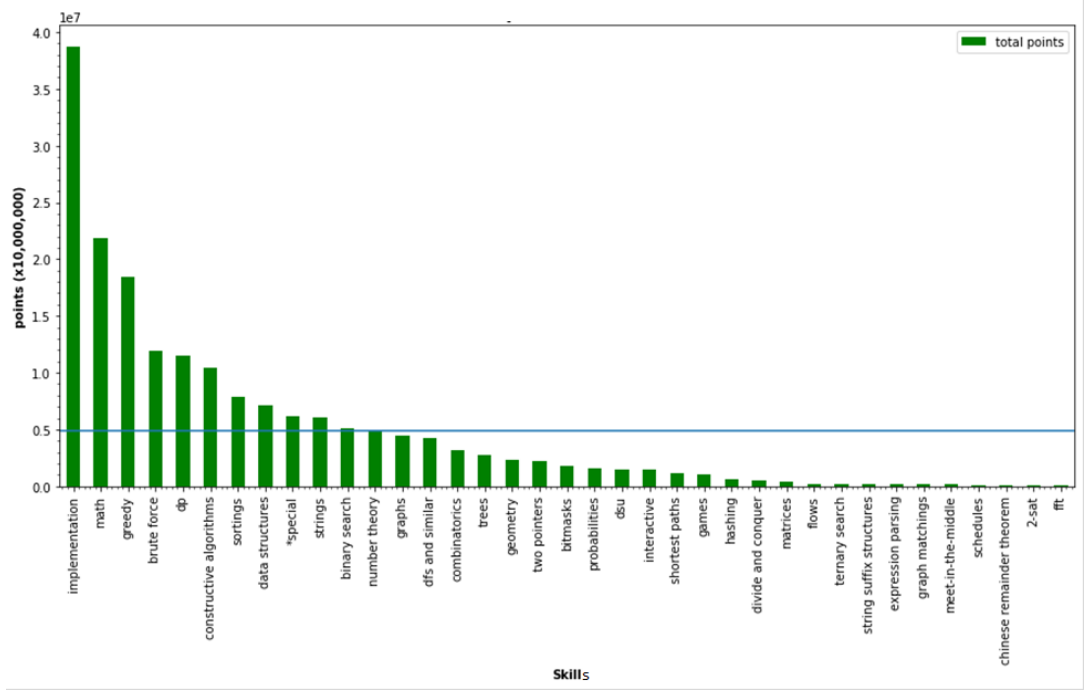
Figure 5. The total number of scores the user has achieved by solving exercises for each skill.